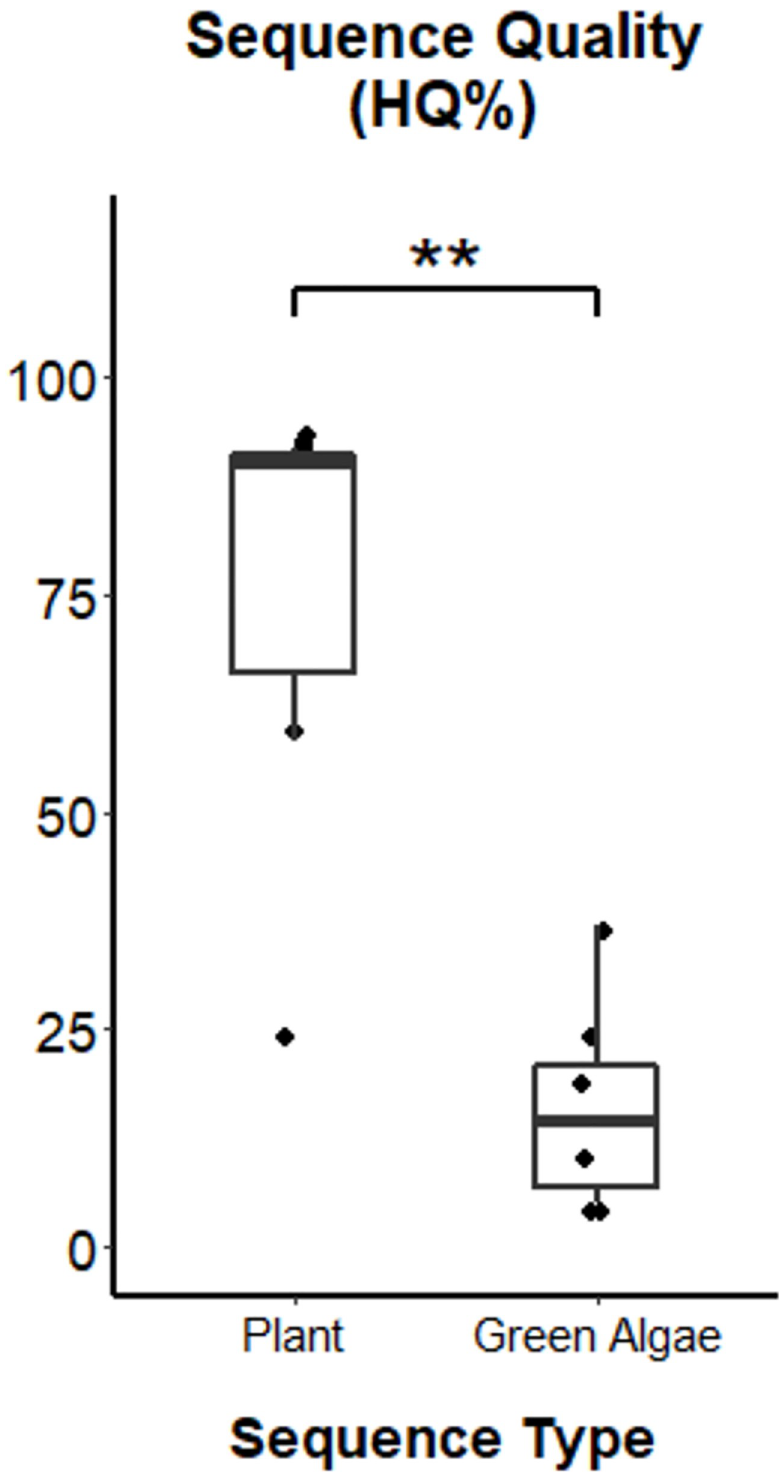
Fig 3. Difference in sequence quality (HQ%) between samples identified as plant and green algae. Significant correlations are indicated as follows: �� p < 0.01.